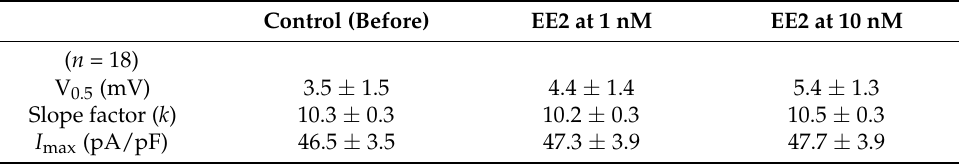
Table 1. Effects of EE2 on voltage-dependence of hERG activation. Before and after a cumulative 5-min exposure from 1 nM to 10 nM EE2, I-V relationships were obtained by the same voltage protocol described in Figure 1D–G. Eighteen cells were used. No significant difference was detected (ANOVA with repeated